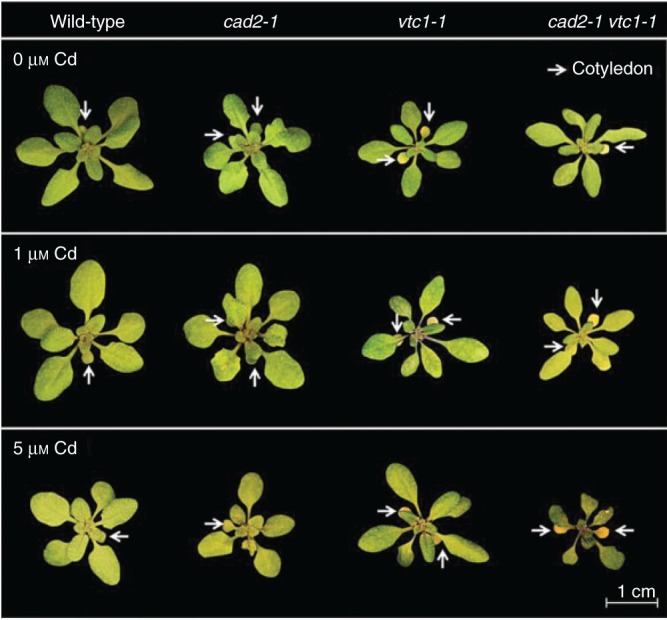
Representative pictures of the rosette appearance of four Arabidopsis thaliana genotypes (wild-type, cad2-1, vtc1-1 and cad2-1 vtc1-1) exposed to 0, 1 or 5 μm CdSO4 for 72 h in hydroponics; n = 28. Cotyledons are indicated by white arrows.